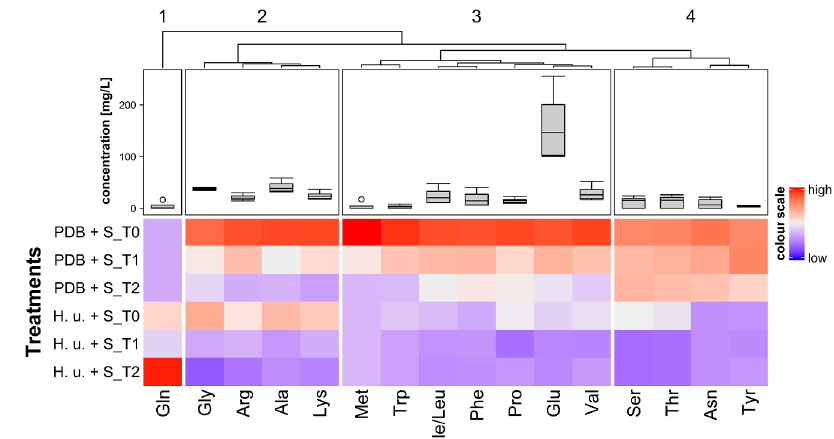
Figure 5. Heatmap of the concentration of amino acids in PDB + S and H. u. + S fermentation broth (T0) and on the surface of leaves treated with PDB + S and H. u. + S collected one day (T1) and one week (T2) after treatment. Three letter codes were used to indicate amino acids. Boxplots show the concentration of amino acids over all six treatments. Clustering of the amino acids was performed using Ward method with Euclidian distance, and the split was based on the k-means algorithm (k = 4).